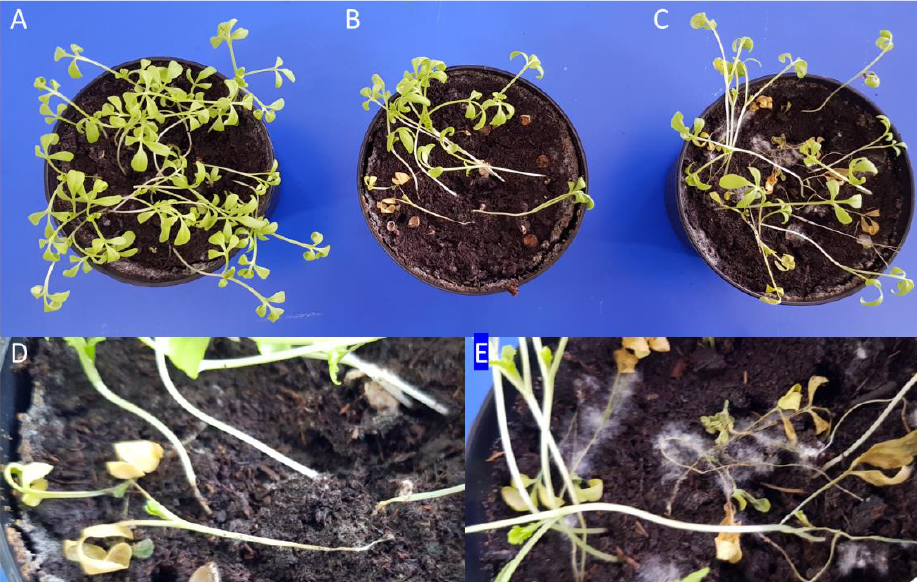
Figure 1. Photograph of healthy ( A ) and Rhizoctonia- ( B ) and Sclerotinia-diseased ( C ) cress seedlings sown in pots on autoclaved peat. Details of the damping-off by Rhizoctonia solani ( D ) and the wilting of cress seedlings covered by Sclerotinia sclerotiorum mold ( E ).